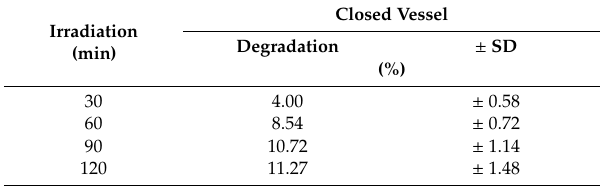
Table 2. Sonolysis: the influence of air on curcumin degradation.